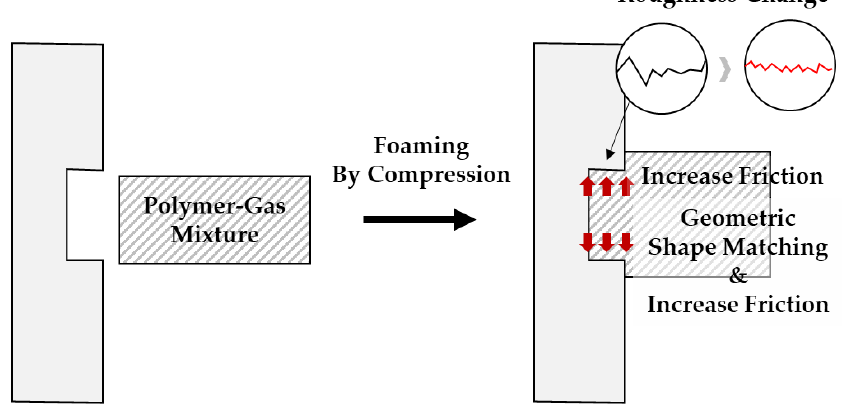
Figure 13. Adhesion between polymers by foaming as potential application. Table 5. Summary of experiment results of research.